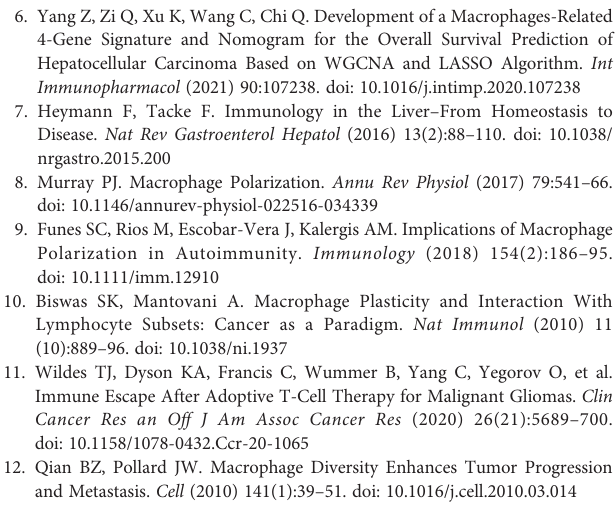
interactions of the macrophage-related differentially expressed genes (interaction score=0.9). (C) The correlation network analysis of the macrophage-related candidate genes (red line: positive correlation; blue line: negative correlation. The intensity of the color re fl ects the degree of its relevance). Supplementary Figure 2 | Coef fi cients for each gene in MRS signature based on the macrophage-related clusters by the LASSO regression algorithm. Supplementary Figure 3 | Kaplan – Meier survival curves for selected genes which obtained by LASSO Cox regression analysis. Supplementary Figure 4 | Verifying protein expression levels of genes from MRS model in normal liver tissue and HCC using the HPA database. Supplementary Figure 5 | MRS signature based on macrophages related clusters was associated with the clinicopathological characters of patients with HCC in the GSE14520 dataset and ICGC dataset. (A) Heatmap for MRS signature based on macrophages related clusters and clinicopathological manifestation in the GSE14520 dataset. (B) Boxplot of risk score based on macrophages related clusters in HCC patients with different size. (C) Boxplot of risk score based on macrophages related clusters in HCC patients with different AFP. (D) Boxplot of risk score based on macrophages related clusters in HCC patients with different multinodular status. (E) Boxplot of risk score based on macrophages related clusters in HCC patients with different stage. (F) Boxplot of risk score based on macrophages related clusters in HCC patients with different cirrhosis status. (G) Boxplot of risk score based on macrophages related clusters in HCC patients with different status of survival. (H) Heatmap for MRS signature based on macrophages related clusters and clinicopathological manifestation in the ICGC dataset. (I) Boxplot of risk score based on macrophages related clusters in HCC patients with different stage. (J) Boxplot of risk score based on macrophages related clusters in HCC patients with different status of survival. Supplementary Figure 6 | (A) Chord diagram illustrating the correlations between the expression of 15 key immune checkpoint genes, as well as between the mRNA expression of 15 key immune checkpoint and the risk score from the MRS signature in TCGA-LIHC dataset. Association between risk score from the MRS signature and (B) BTNL2, (C) CD274, (D) CD276, (E) CTLA4, (F) HAVCR2, (G) IDO1, (H) LAG3, (I) LAIR1, (J) NP1, (K) PDCD1, (L) TDO2, (M) TIGHT, (N) TNFRSF14-AS1, (O) VSIR, (P) VTCN1. Supplementary Figure 7 | Association between risk score from the MRS signature and (A) TIDE score and (B)0 neoantigen burden per MB. Supplementary Figure 8 | Gene expression levels across groups of different responses to ICBs in syngeneic mouse